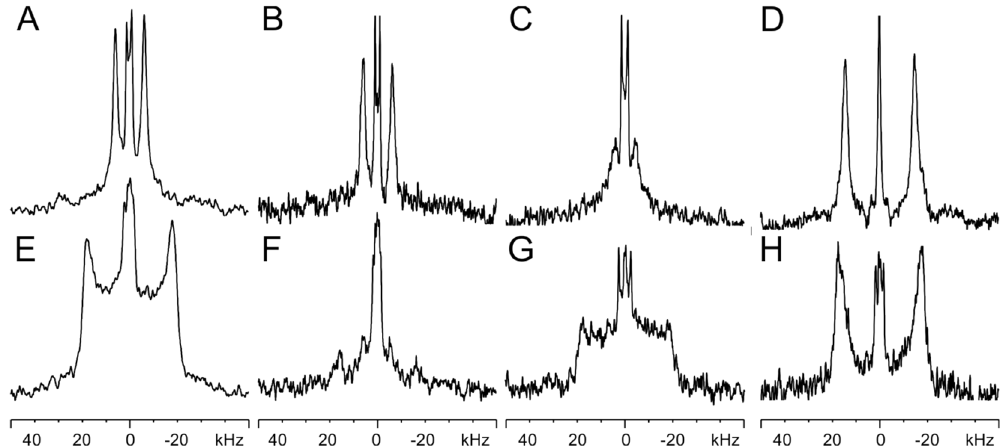
Figure 5. 2 H solid-state NMR spectra of 2 mol% [3,3,3- 2 H 3 -Ala24]-CRAC-TM_model ( A , E ), [3,3,3- 2 H 3 - Ala24]-CRAC-TM_model2 with a single I to L substitution within the CRAC domain ( B , F ), [3,3,3- 2 H 3 -Ala24]- CRAC-TM_model with a scrambled CRAC amino acid arrangement of the CRAC domain ( C , G ) and of [3,3,3- 2 H 3 -Ala29]-CRAC-TM_gp41 reconstituted into uniaxially aligned POPC lipid bilayers ( D , H ) without ( A – D ) and with cholesterol ( E – H ). The membrane normal was parallel to the magnetic field of the NMR spectrometer and the experiments were performed at room temperature. The central contributions exhibiting small quadrupolar splittings and isotropic resonances are from residual HDO 74